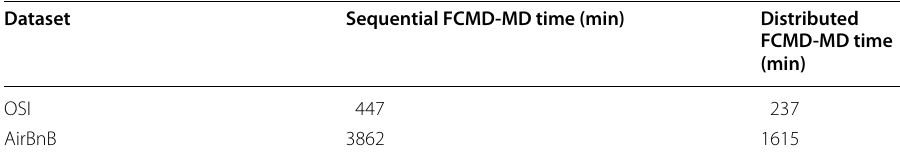
Table 12 Time consumed by distributed and sequential version of FCMD-MD